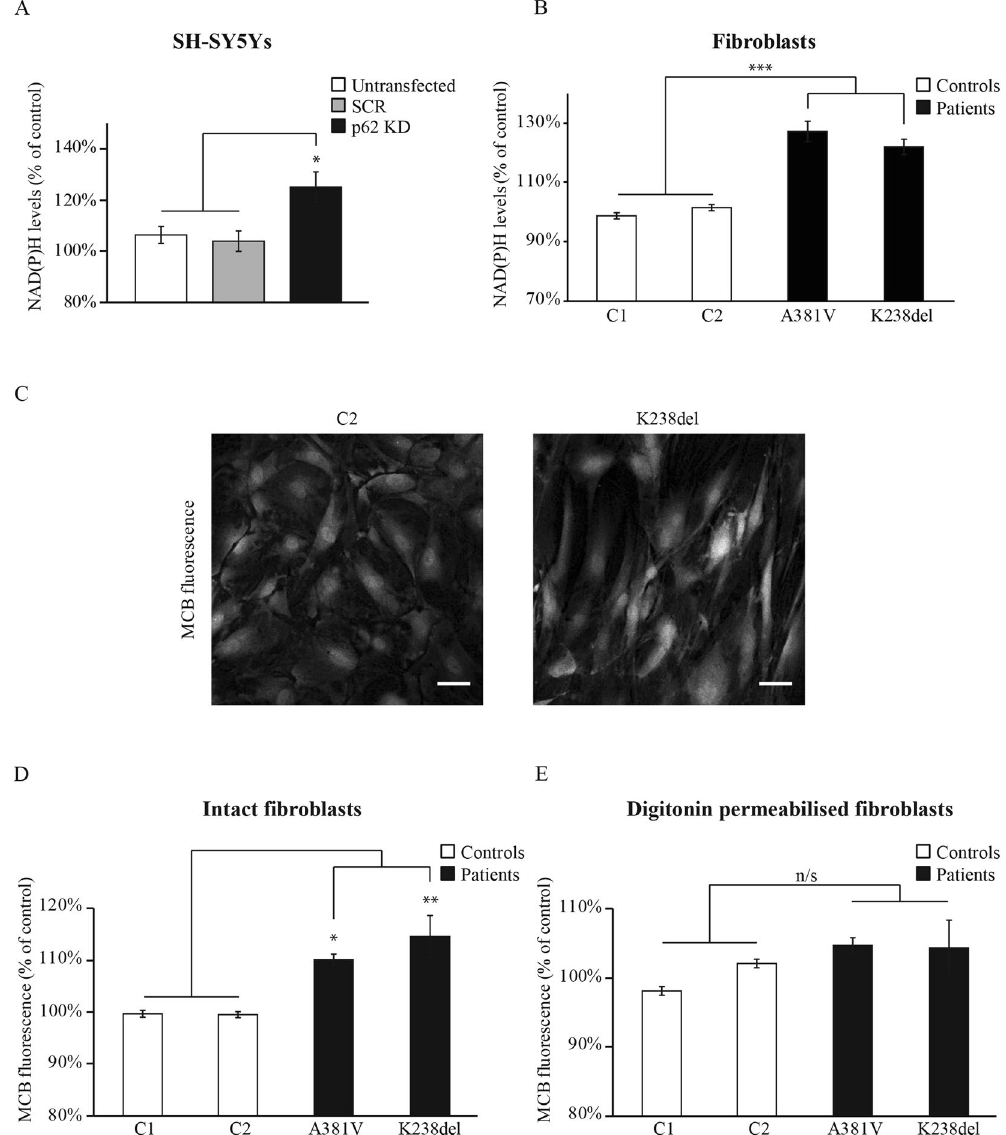
Figure 6. Pentose phosphate pathway activity is increased upon p62 deficiency. ( A,B ) NAD(P)H levels were obtained through the analysis of NADH autofluorescence. The NAD(P)H values were calculated by subtracting the background from the minimum fluorescence after addition of FCCP (1 μ M) which oxidises all the mitochondrial NADH minimising the NADH fluorescence (see Fig. 2B). NAD(P)H levels from untransfected, SCR and p62 KD SH-SY5Y cells ( A ) and control and p62-deficient fibroblasts ( B ) representing the mean of at least 3 independent experiments ± SEM. * indicates p < 0.05 and *** indicates p < 0.001 compared with the values in control cells. ( C–E ) GSH levels were analyzed by measuring the monochlorobimane (MCB) fluorescence. Representative images showing the cell fluorescence after MCB incubation (50 μ M) in fibroblasts from control 2 (C2) and patient 2 carrying the K238del mutation ( C ). Scale bar represents 44 μ m. The GSH levels were obtained after evaluation of the MCB fluorescence in fibroblasts from all p62 mutant carriers and the obtained values were compared to those from the control fibroblasts before ( D ) and after digitonin treatment (40 nM) ( E ). All data represents the mean of at least 3 independent experiments ± SEM. In all cases * indicates p < 0.05 and ** indicates p < 0.01 compared with the values in control